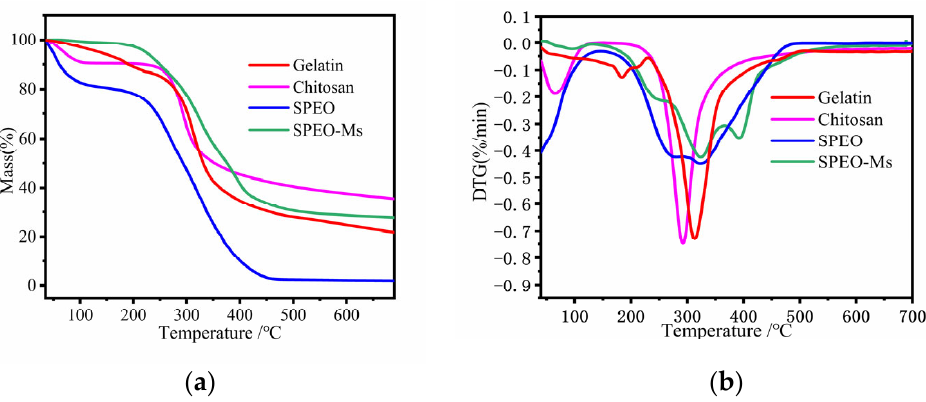
Figure 8. TGA ( a ) and DTG ( b ) curves for gelatin, chitosan, SPEO and SPEO microcapsules.